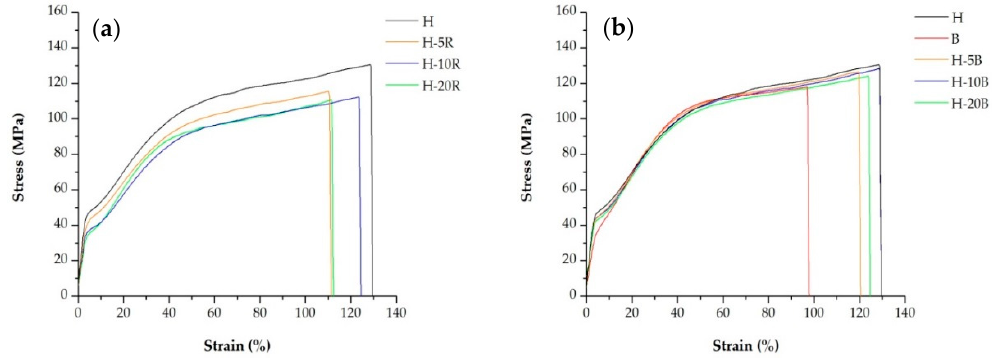
Figure 8. Stress-strain curves of precursor films annealed at 140 °C, for the PP homopolymer and its blends with the ( a ) random and ( b ) block copolymers.